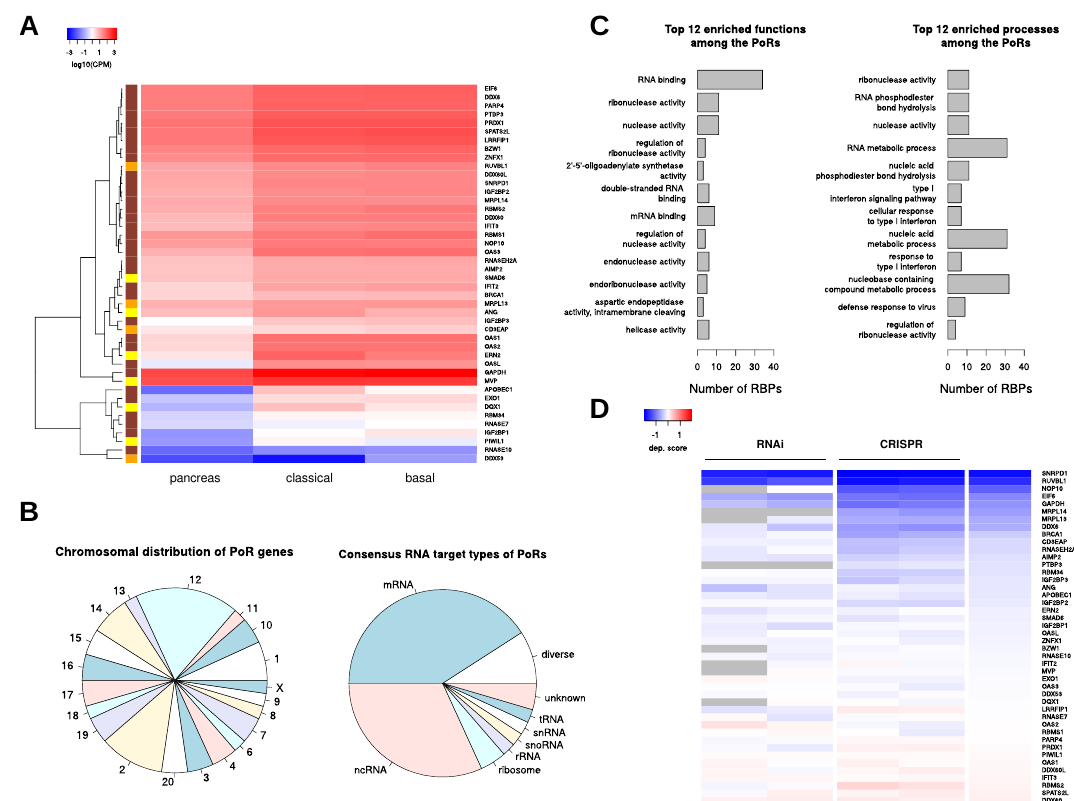
Figure 3. Properties of PDAC onco-RBPs (PoRs). ( A ) Average normalized RNA expression values (log10 CPM) of the 44 PoRs in pancreas as well as in classical and in basal-like PDAC samples. The color bar on the left side encodes subtype specificity of oncogene properties (yellow—upregulated and adverse prognostic only in classical PDAC; orange—upregulated and adverse prognostic only in basal-like PDAC; brown—upregulated and adverse prognostic in both PDAC subtypes). ( B ) Chromosomal distribution ( left ) and consensus RNA target types ( right ) of the PoRs. ( C ) Top 12 significantly (FDR < 0.05) enriched functions (left) and biological processes (right) among the PoRs. Gene Ontology terms are sorted according to the significance of their enrichment. ( D ) Average dependency scores of the PoRs in PDAC subtype specific cell lines obtained by knockdown via RNAi or CRISPR knockout. Gray color denotes missing